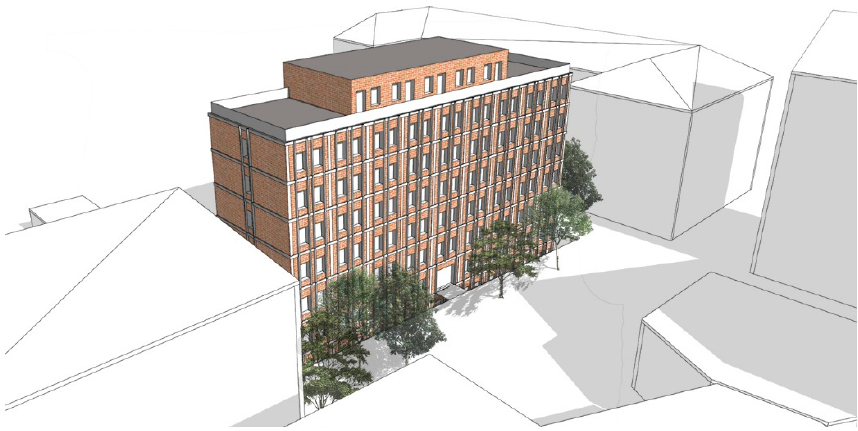
Figure 1. 3D model of the office building and the surrounding buildings. Table 2. Physical data of the existing building envelope components.